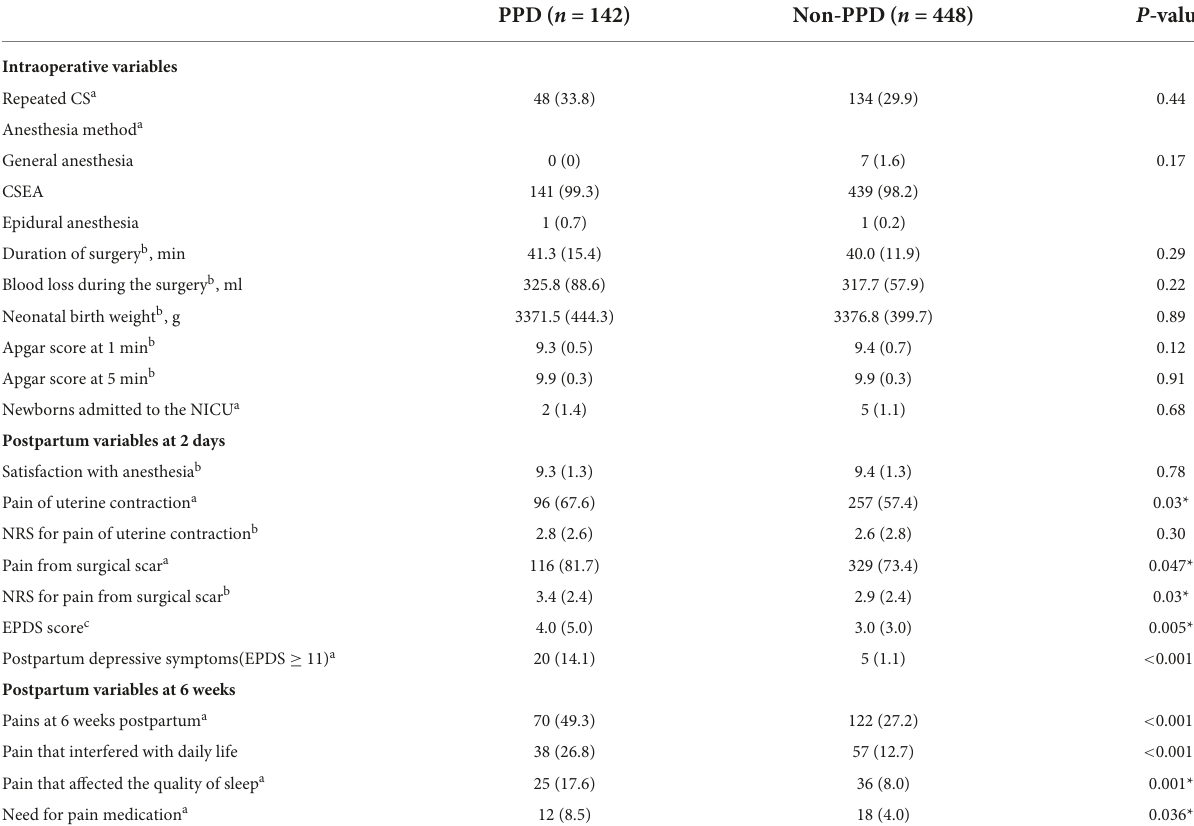
TABLE 2 Distribution of the study participants by intraoperative and postpartum characteristics.